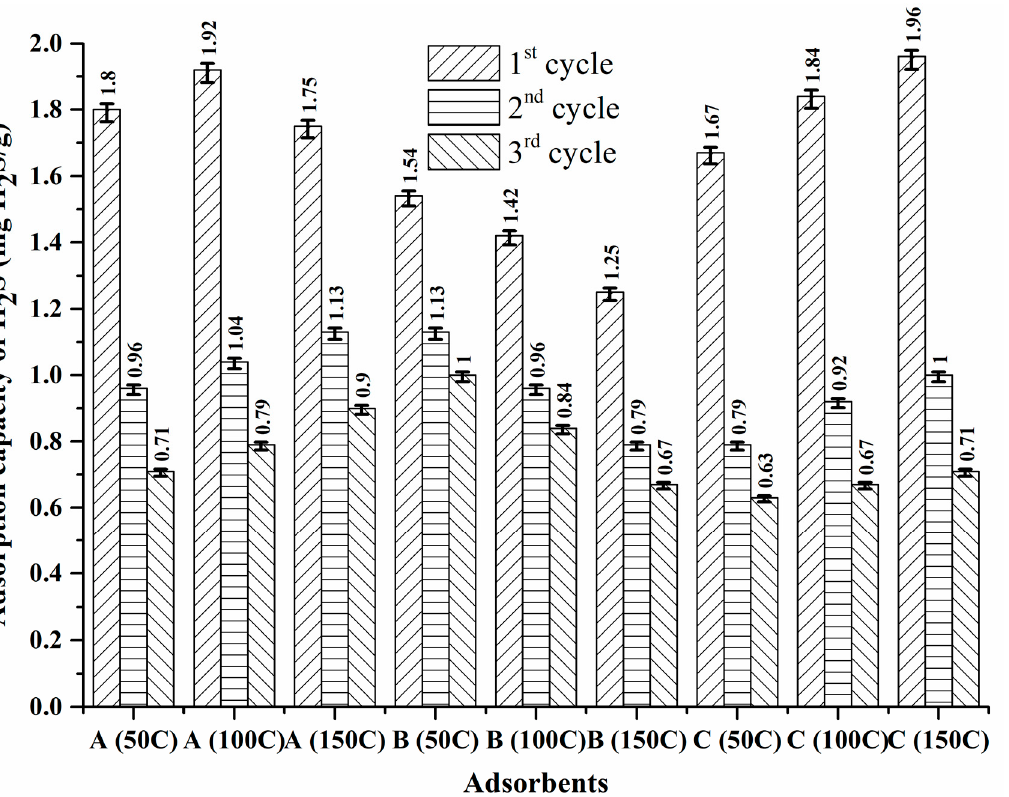
Figure 8. H 2 S adsorption capacity throughout the three adsorption–desorption cycles for (A) ZnAc 2 /ZnO/CAC_DCM, (B) ZnAc 2 /KOH/CAC_DCM, and (C) ZnAc 2 /TiO 2 /CAC_DCM/CAC. When a low temperature (50 °C) was used in the process of desorption, the adsorp- ZnAc 2 /ZnO/CAC_DCM adsorbent, showing reductions of 46.7% in the second cycle and of another 26.0% in the third cycle. However, the low-temperature adsorption process with ZnAc 2 /TiO 2 /CAC_DCM and ZnAc 2 /KOH/CAC_DCM was better than the adsorption